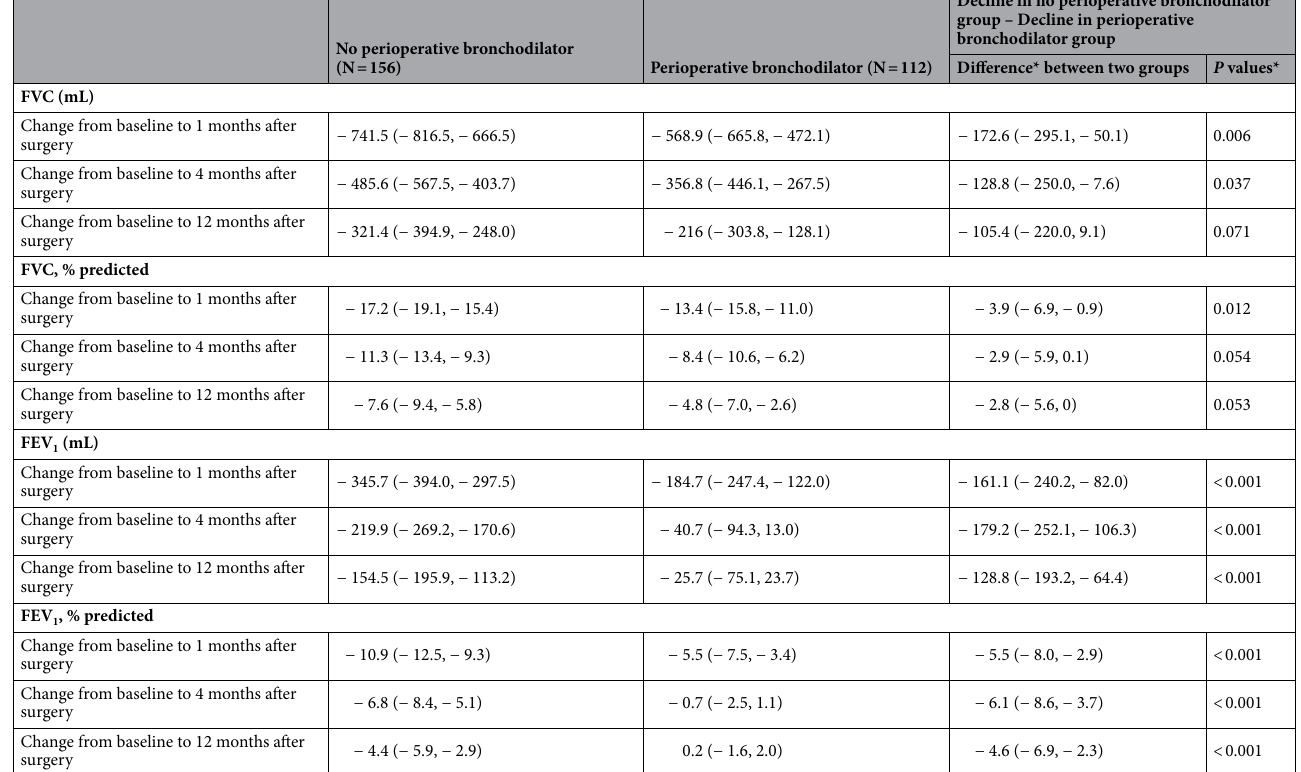
Table 2. Changes in pulmonary function from baseline to 1, 4, and 12 months following lung resection according to perioperative bronchodilator use. Adjusted for age, sex, body mass index (underweight, normal, overweight, or obese), smoking status (never, past, or current), surgical extent (limited resection, lobectomy, bilobectomy, or pneumonectomy), VATS, and preoperative baseline FEV 1 (mL). *Differences in pulmonary function changes between the “no perioperative bronchodilator” group and the “perioperative bronchodilator”